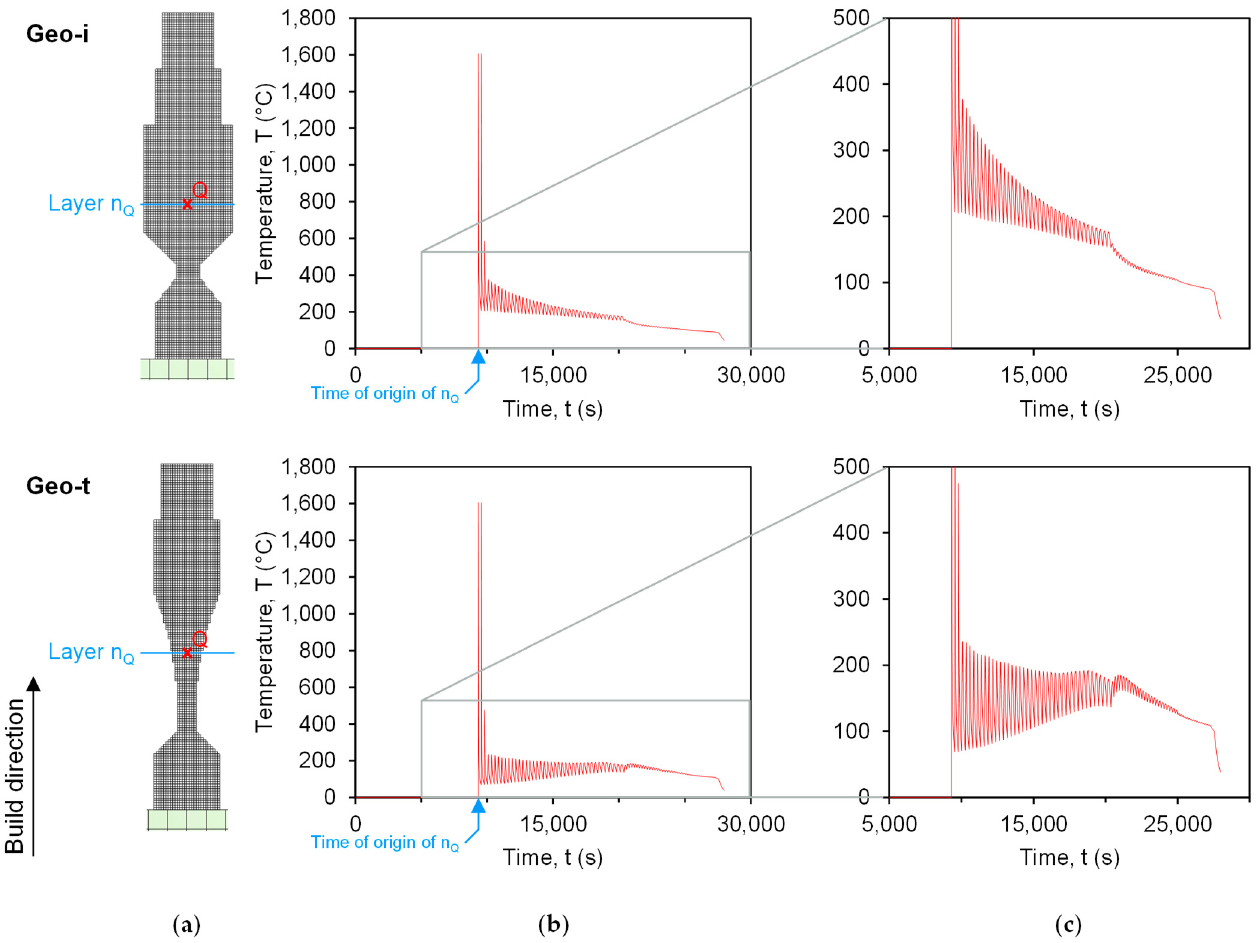
Figure 10. ( a ) Exemplary geometry variants Geo-i and Geo-t with evaluation point Q in corresponding layer n Q , ( b ) Time-temperature profile (thermal history) at Q with time of origin of marked layer n Q , ( c ) enlarged section of the thermal history at Q.